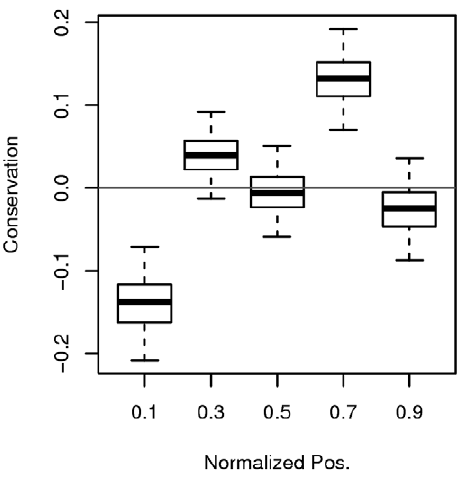
Figure 3. Positional bias of conservation for viral proteins. For each viral protein which also contained at least one tested peptide from Table 1, conservation scores at the residue-level were calculated using Rate4Site [26]. Residue positions were converted into normalized positions and corresponding conservation scores were binned (5 bins of equal size). Higher conservation score indicates higher degree of conservation. Conservation scores were normalized for each protein (i.e. mean=0; sd=1). One thousand bootstrapping over proteins was used to estimate confidence intervals for the means of conservation scores. Each box covers 25 th and 75 th percentiles. Whiskers extend out from each box 1.0 times the interquartile range.